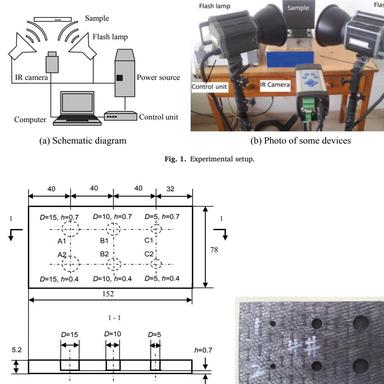
Sample A.